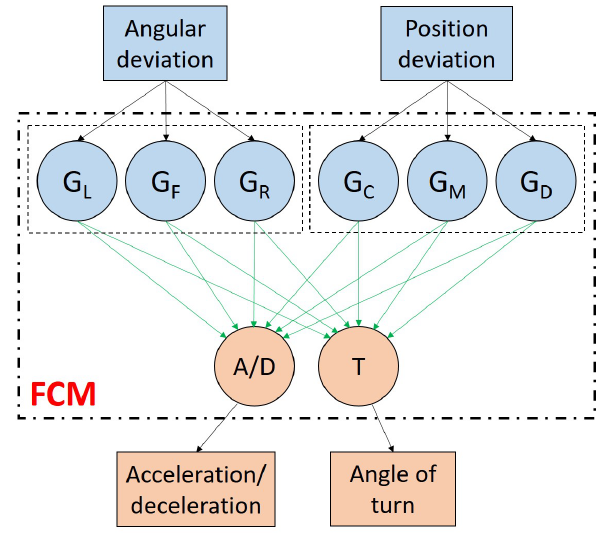
Figure 9. Proposed architecture of navigation FCM.